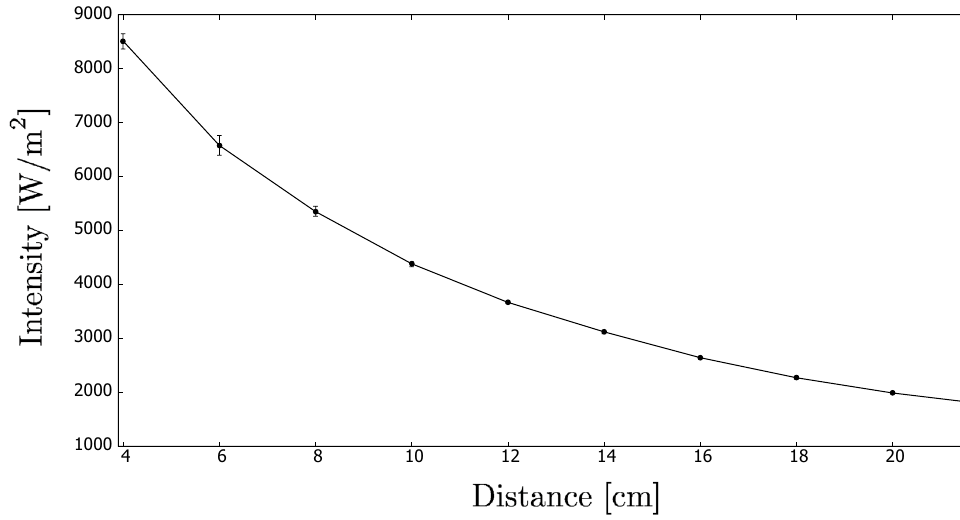
Figure 5. Intensity of the halogen lamp vs. distance.